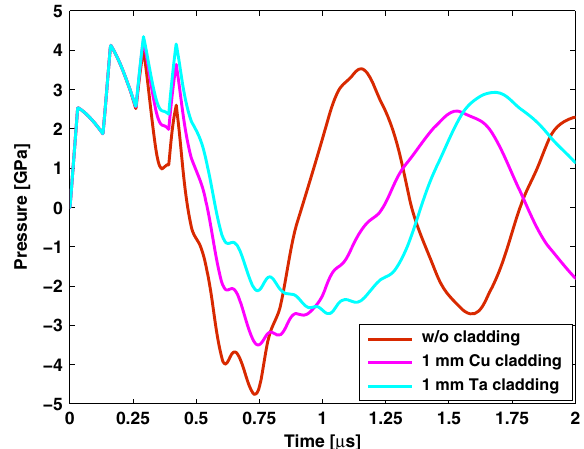
FIG. 12. Pressure reached in the center of the target core (gauge 7) for the three scenarios of study. Assuming Johnson- Cook strength model for the tungsten core and models consid- ering plasticity in the cladding consistently with Table I. No failure models are considered. The plot shows the reduction of the reached tensile pressure when using